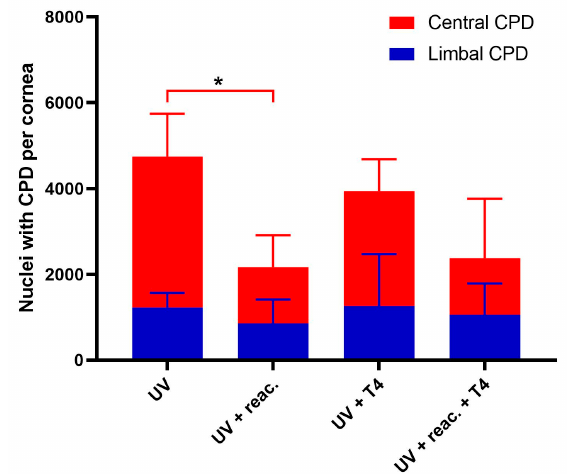
Figure 10. Bar chart of the number of CPD-positive nuclei in irradiated CPDPL tg/wt mouse corneas. Each column represents the total number of CPD-positive nuclei in the cornea, the red portion represents the nuclei in the center of the cornea, and the blue portion represents the nuclei in the limbus. There was no significant change in limbal CPDs noted after treatment with T4N5 or activation of CPDPL. Central CPD change was only noted after photoreactivation (* is p < 0.05).